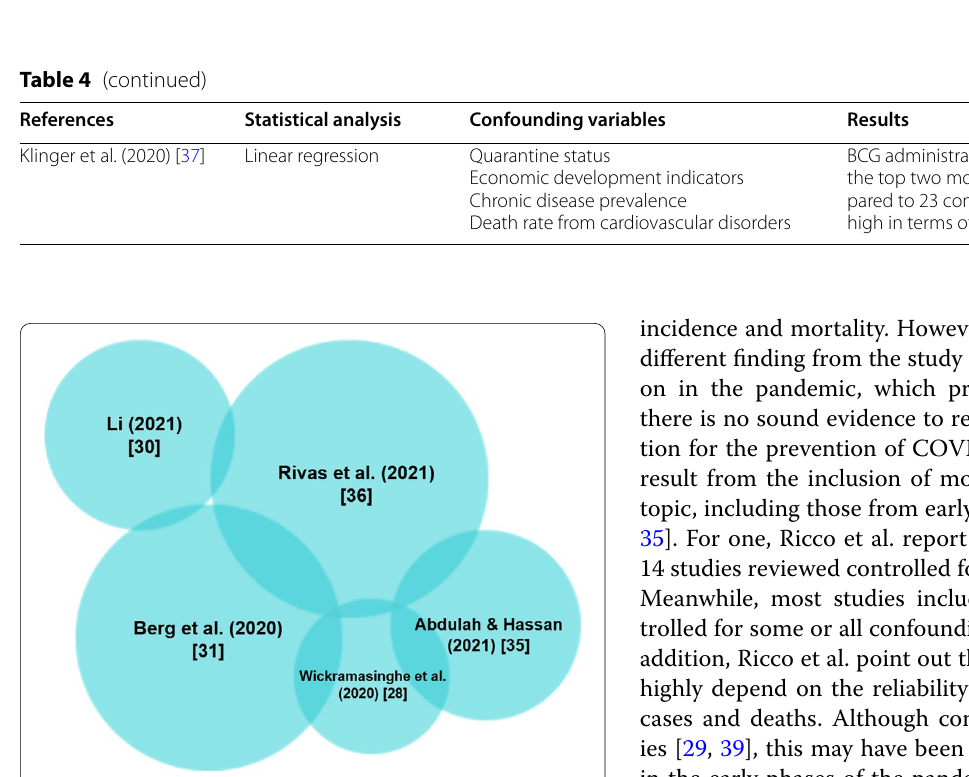
Fig. 2 Heat map of the magnitude of association between presence of national BCG Vaccination Policies and COVID-19 morbidity